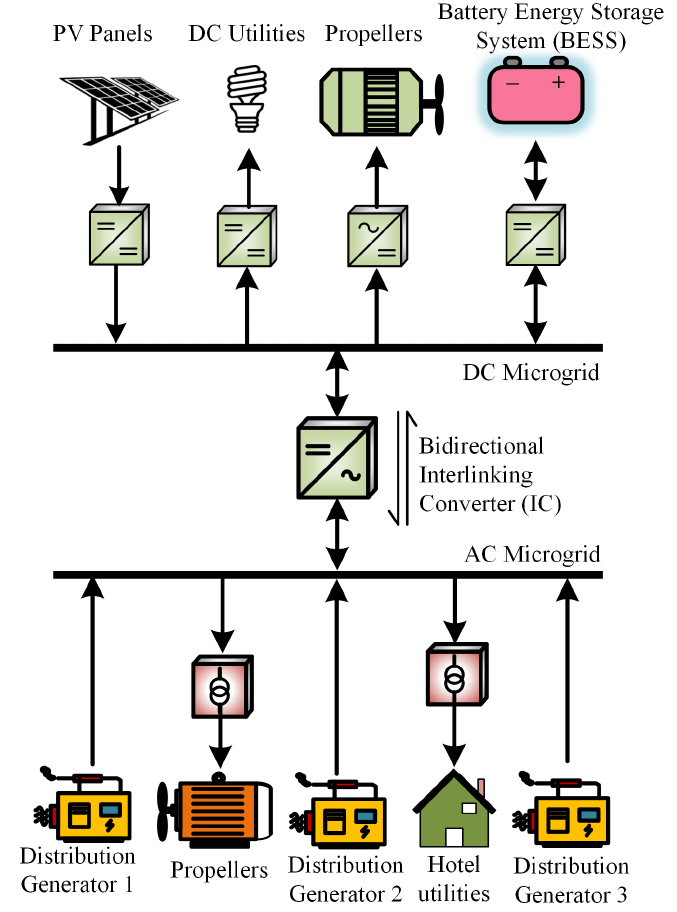
Figure 1. Structure of a hybrid shipboard Microgrid